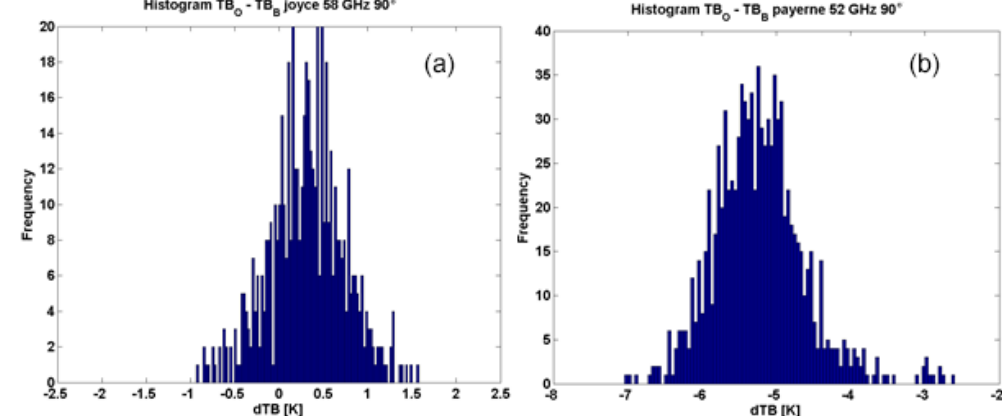
Figure 7. Histograms of the O–B TB differences. Panel (a) refers to JOYCE at 58.00GHz and 90 ◦ elevation angle, while panel (b) refers to Payerne at 52.28GHz and 90 ◦ elevation angle.